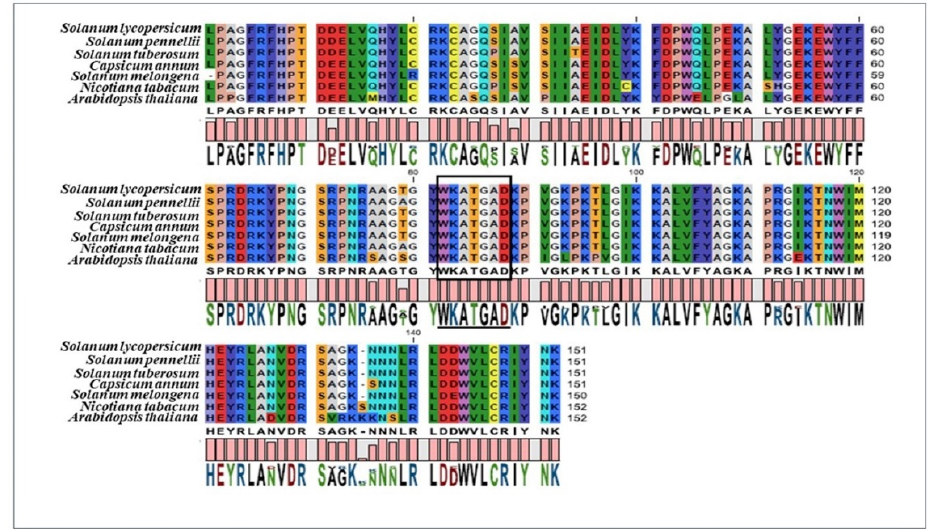
Figure 2. Multiple sequence alignment of conserved functional NAC domain region among different members of the solanaceous family and model plant Arabidopsis thaliana in the present study. Multiple sequence alignment analysis confirmed that the slightest discrepancies occurred in the WKAT motif during evolution and might exert a functional role in the interaction of NAC proteins with cis- regulatory elements.